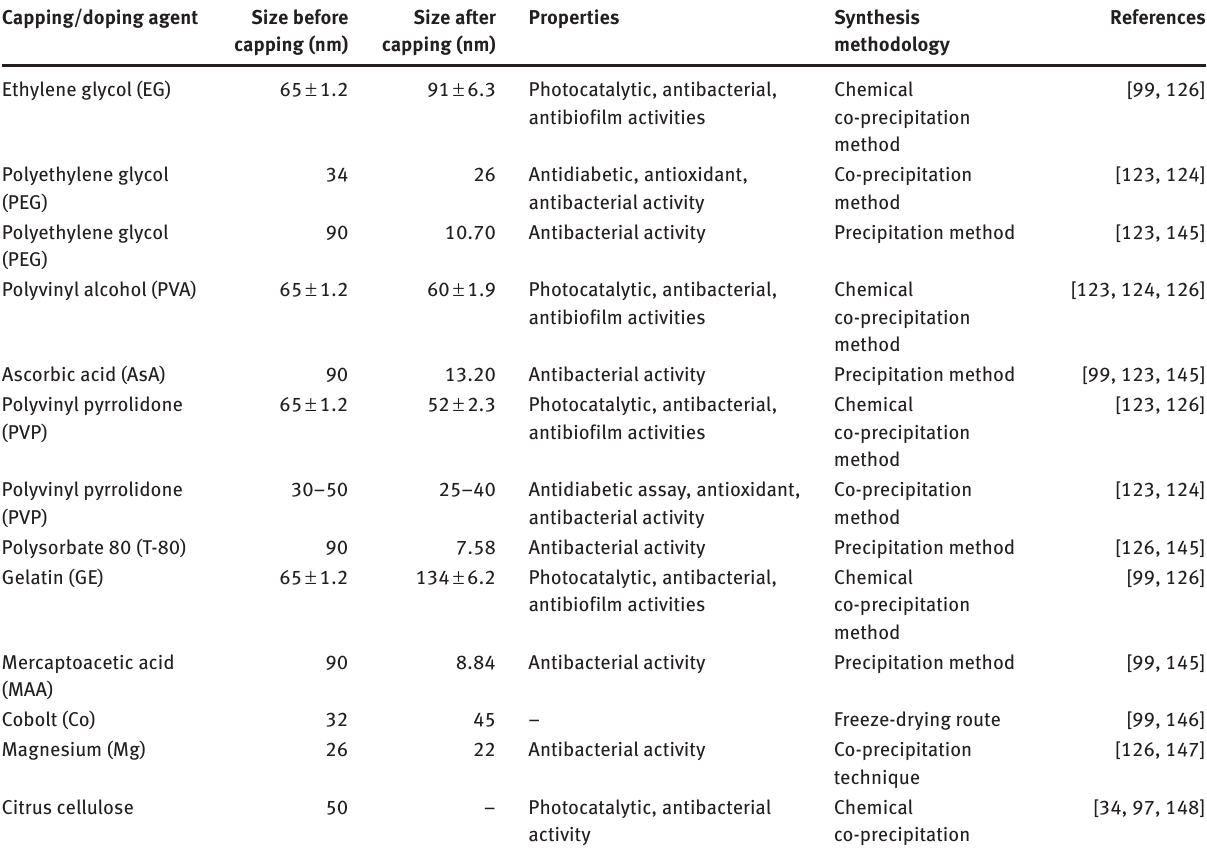
Table 5: Brief description of properties of ZnO NPs and effect capping/doping agents on size. Capping/doping